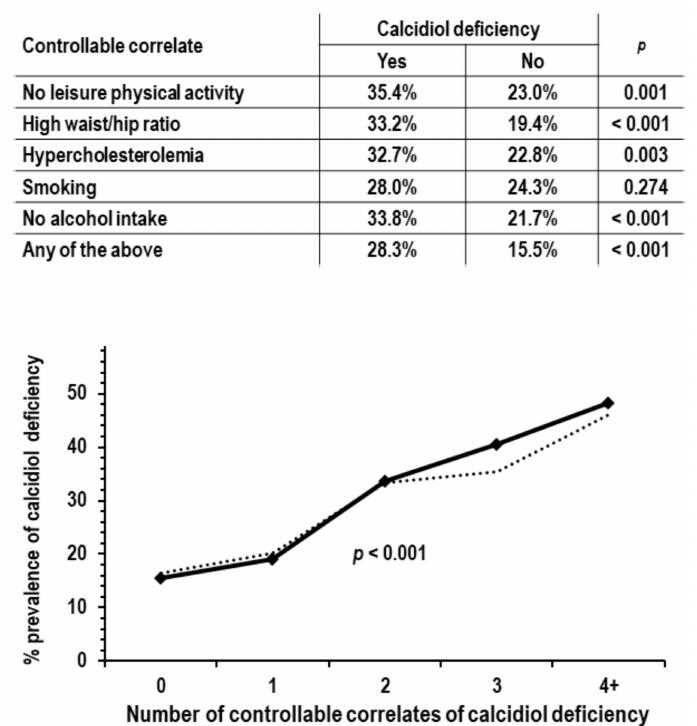
Figure 1. Analyses on the associations of controllable traits correlated with calcidiol deficiency; analyses were limited to the 952 examinees not reporting the use of vitamin D supplements; p values are by chi-square analysis. Upper tabular insert : calcidiol deficiency prevalence in the group with no leisure physical activity compared to the group with leisure physical activity ( n = 158 and 794), in the group with high waist/hip ratio compared to the group without high waist/hip ratio ( n = 394 and 558), in the group with hypercholesterolemia compared to the group without hypercholesterolemia ( n = 223 and 729), in smokers compared to non-smokers ( n = 207 and 745), in non-drinkers compared to drinkers ( n = 269 and 683), and in the group with any of the above traits compared to the group without any of the above traits ( n = 713 and 239). Lower graph : prevalence of calcidiol deficiency by number of controllable traits correlated with calcidiol deficiency (range from 0 to 5, n = 239, 336, 247, 101, 27, and 2). Due to low n , groups with 4 and 5 traits were combined in a single group indicated as 4+. The dotted line indicates prevalence of calcidiol deficiency in ANOVA with control for sex, age, solar irradiance, systolic pressure, and